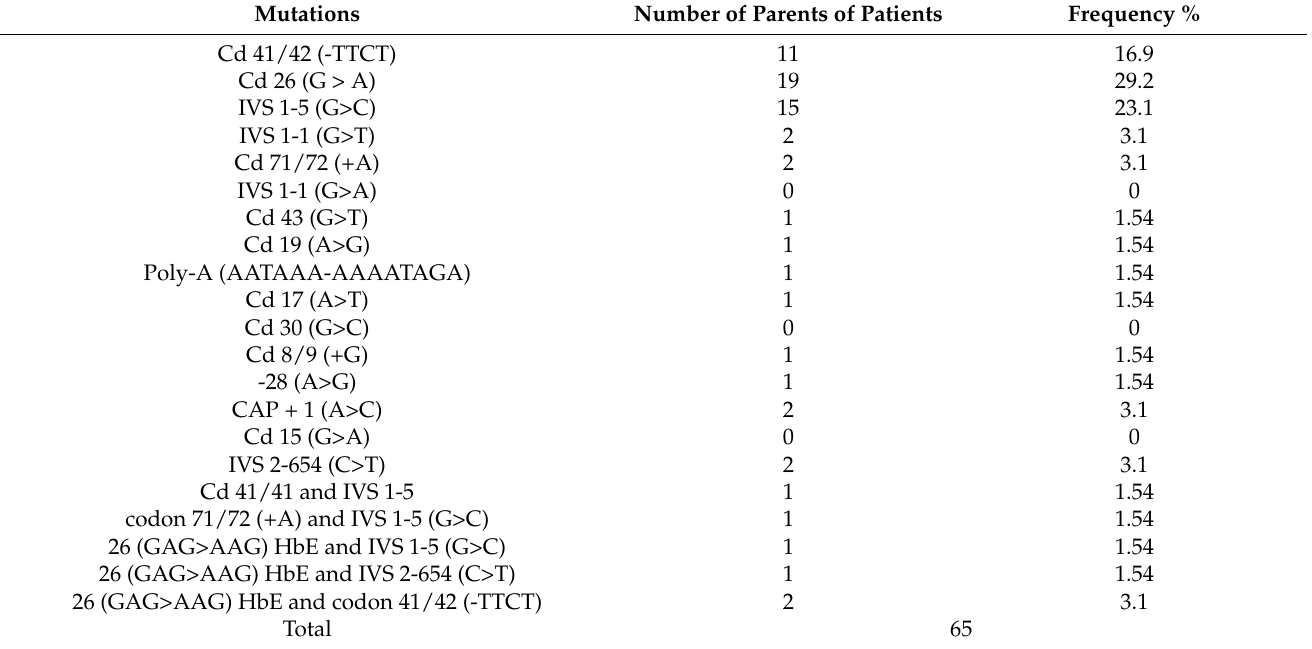
Table 5. Types of heterozygous and homozygous β -globin gene mutations identified in parents of